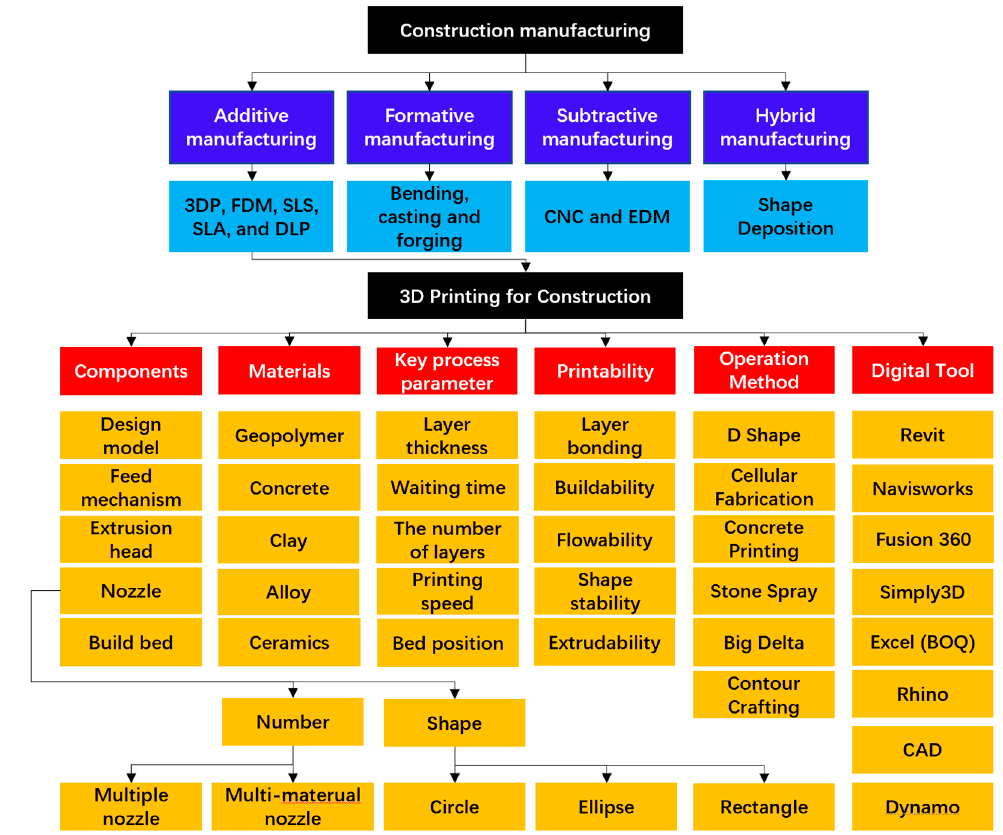
Figure 13. Taxonomy of 3DP systems, digital tools, operation methods and required materials for three-dimensional printing in construction. Note: FDM: fused deposition modelling; SLS: selective laser sintering; SLA: stereolithography apparatus; DLP: digital light processing; CNC: computerized numerical control; EDM: electrical discharge machining; BOQ: bill of quantities.